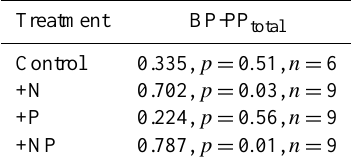
Table 3. Pearson correlation coefficients between bacterial produc- tion (BP) and total particulate primary production for the Control, +N, +P and +NP additions pooled from the three